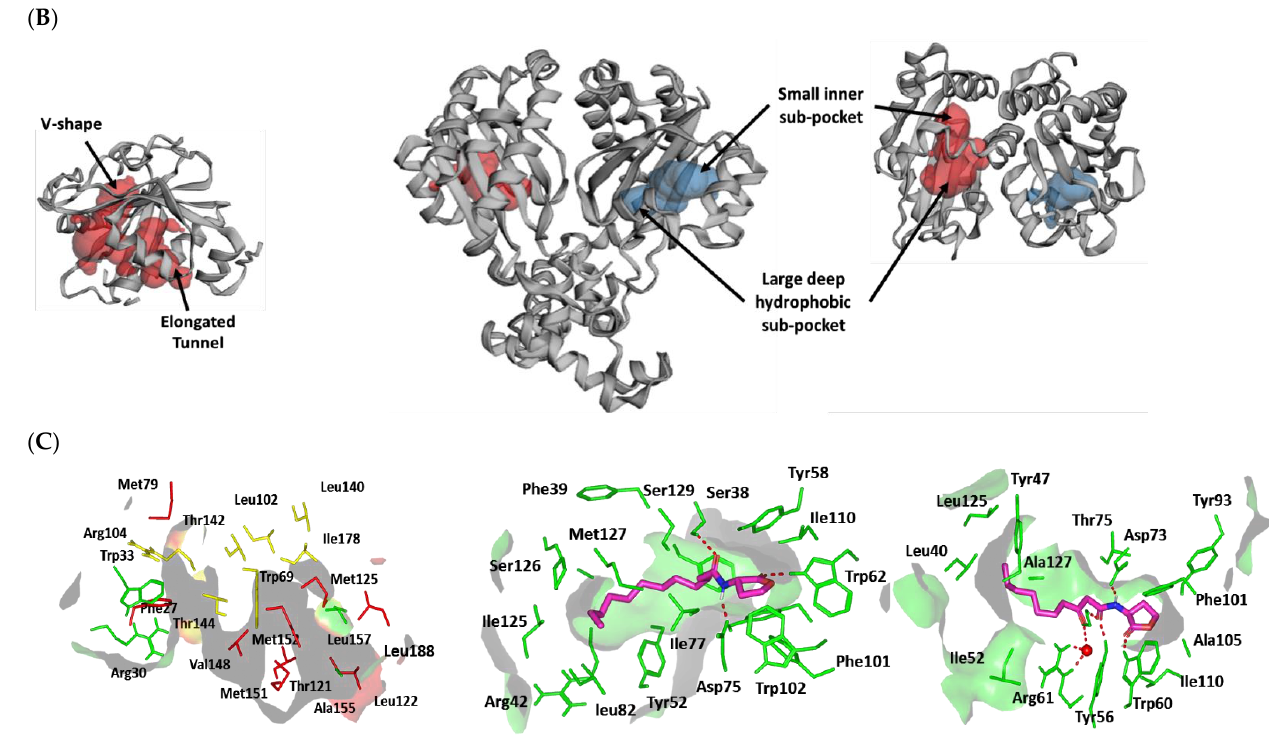
Figure 6. Architectures of three P. aeruginosa virulence-regulating biological targets. ( A ) Overall 3D cartoon representations of the P. aeruginosa LasI-type AHL synthase ligand-binding domain (PDB ID: 1R05; right panel), as well as QscR (PDB ID: 6CC0; middle panel) and LasR (PDB ID: 6MVN; right panel) quorum-sensing transcription proteins. Each quorum-sensing protein is colored differently in regard to its ligand-binding domain (LBD) and/or DNA-binding domain (DBD) as light/dark green and dark/light orange for protomers A and B, respectively. Ligands are represented as magenta spheres with the exception of LasI AHL synthase, where no ligand was co-crystallized with the protein. ( B ) Calculated putative pockets of the binding site topology at the three P. aeruginosa biological targets via the web-based Computed Atlas of Surface Topography of proteins (CASTp) server (http://sts.bioe.uic.edu/castp/index.html; accessed on 30 October 2021) using 1.4 Å radius probe, visualized as surface 3D representation, and colored in different colors (blue and red) for each target protomer. Estimated pocket area and volume were analytically calculated using Richard’s solvent-accessible surface model. ( C ) Surface representation of the binding site with an overlay of whichever co-crystallized ligand (magenta sticks) of its respective bacterial target is present: C 12 - HSL (6CC0) and 3-O-C 10 -HSL (6MVN). Hydrogen bonding is shown as dashed lines (red), while residues (green lines), only amino acids located within 5 Å radius distance from the bound ligand, are displayed and labeled in sequence numbers. Crystallized water molecule bridging the ligand/residue interactions is shown as red sphere.